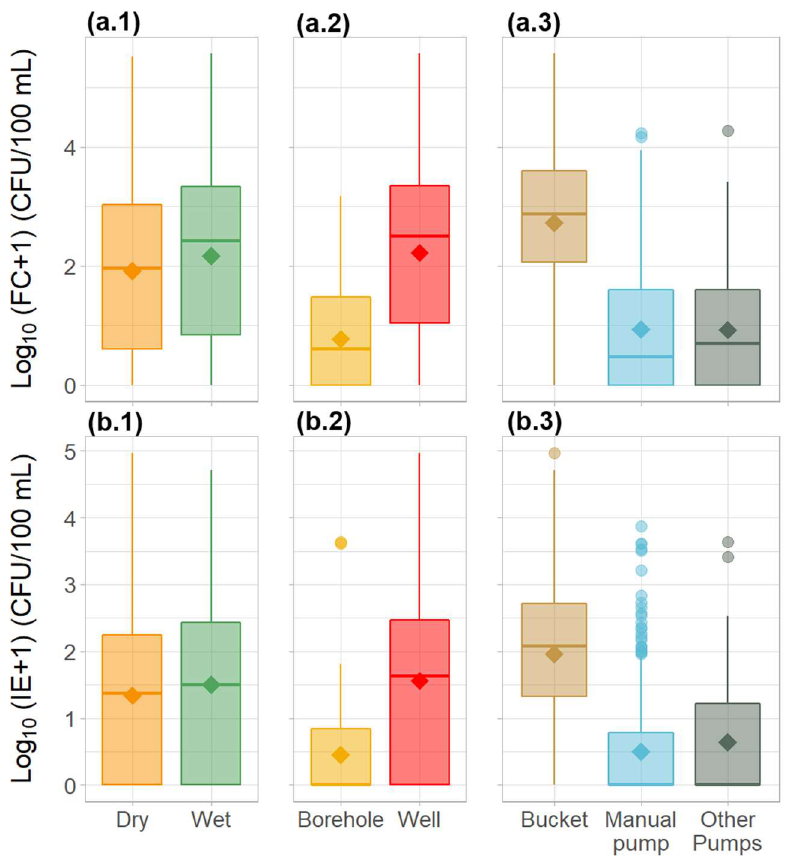
Figure 2. Variation in the microbiological water quality parameters—( a ) faecal coliforms and ( b ) intestinal enterococci—in the water sources across Guinea-Bissau between (1) seasons, (2) source type, and (3) method of water collection. Diamond shapes represent the mean. Circles represent outliers.